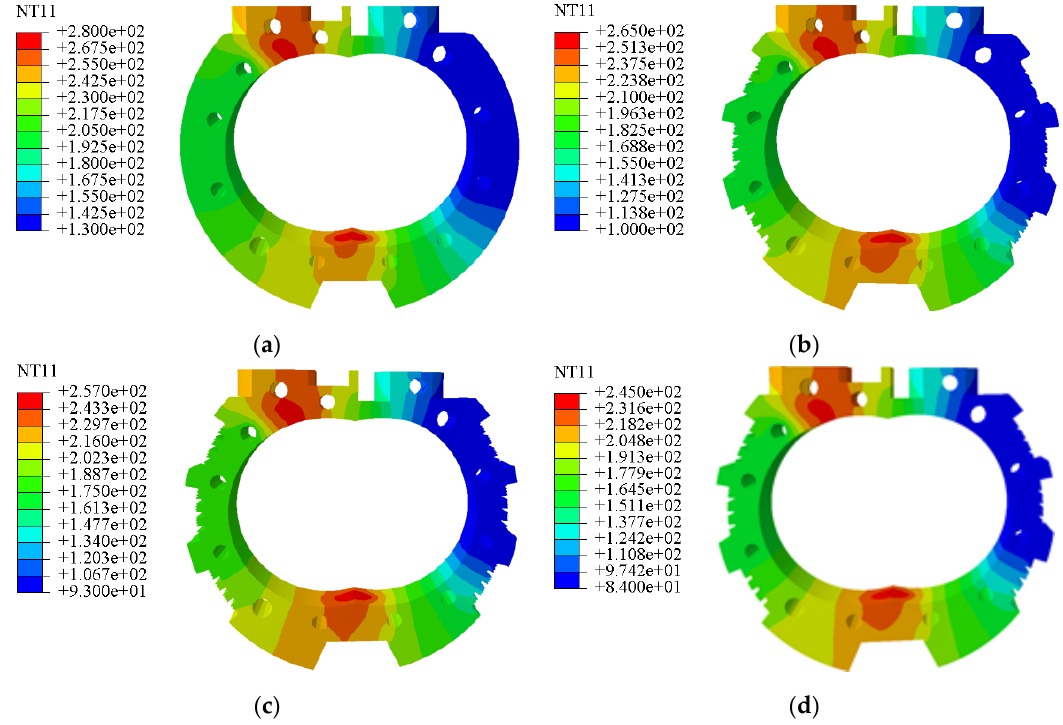
Table 3. Temperature results of the cylinder without microtextures and with microtextures at different widths.